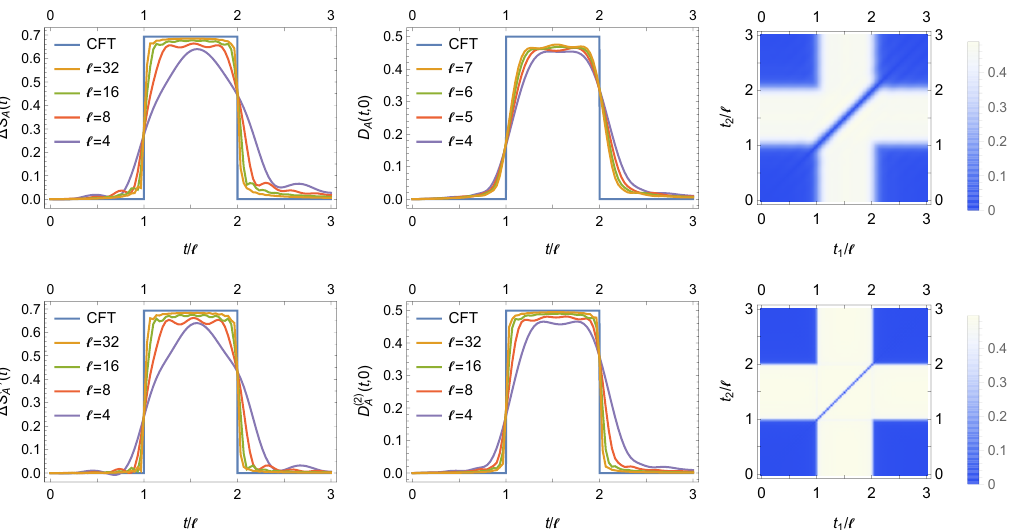
Figure 5 . The same as in (cid:12)gure 4 for the linearized Ising model. Note the much faster approach to the CFT predictions compared to the actual spin chain in (cid:12)gure